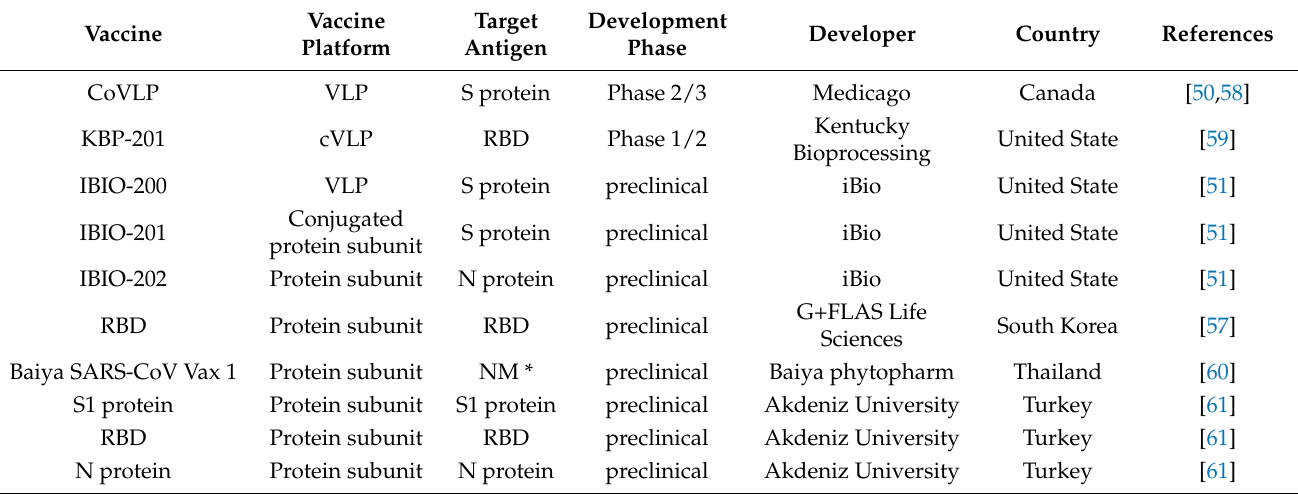
Table 1. Plant-based coronavirus disease 2019 (COVID-19) vaccine candidates.